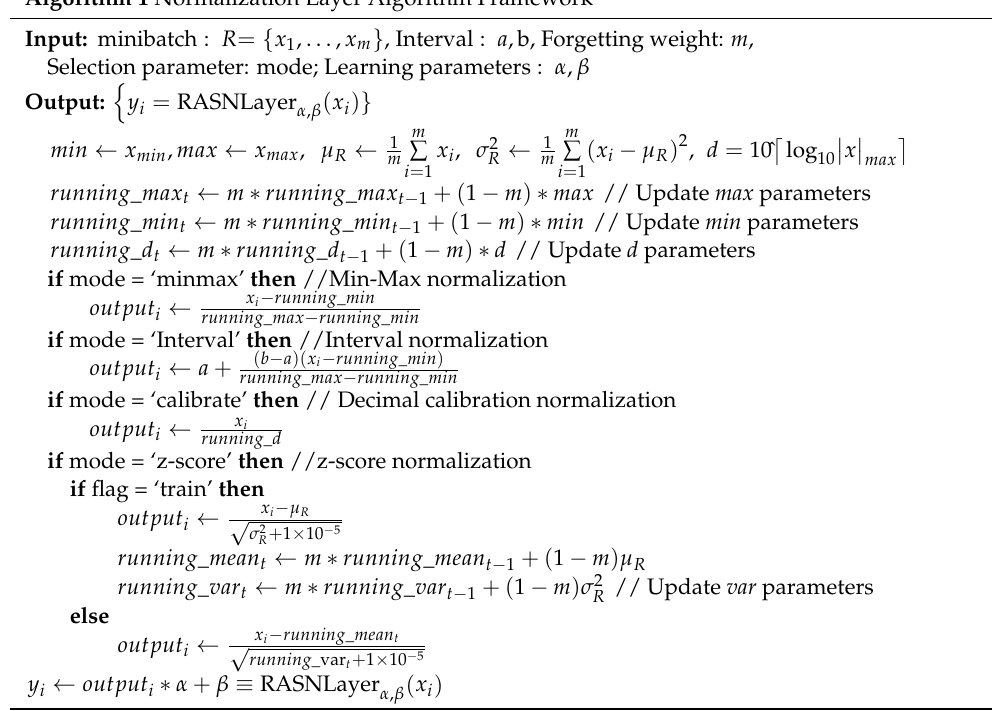
Algorithm 1 Normalization Layer Algorithm